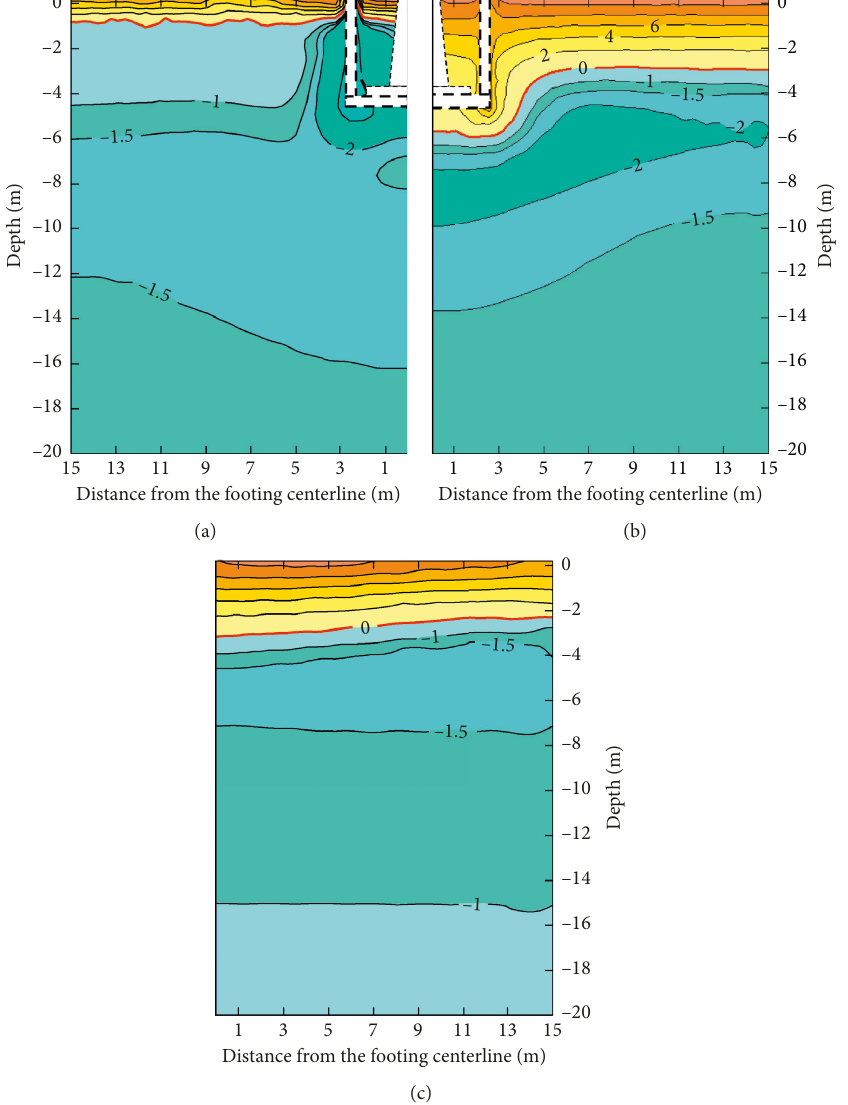
F IGURE 16: Effect of the adjustable stuffer on the temperature distributions on July 15. (a) Close. (b) Open. (c) No ventilation